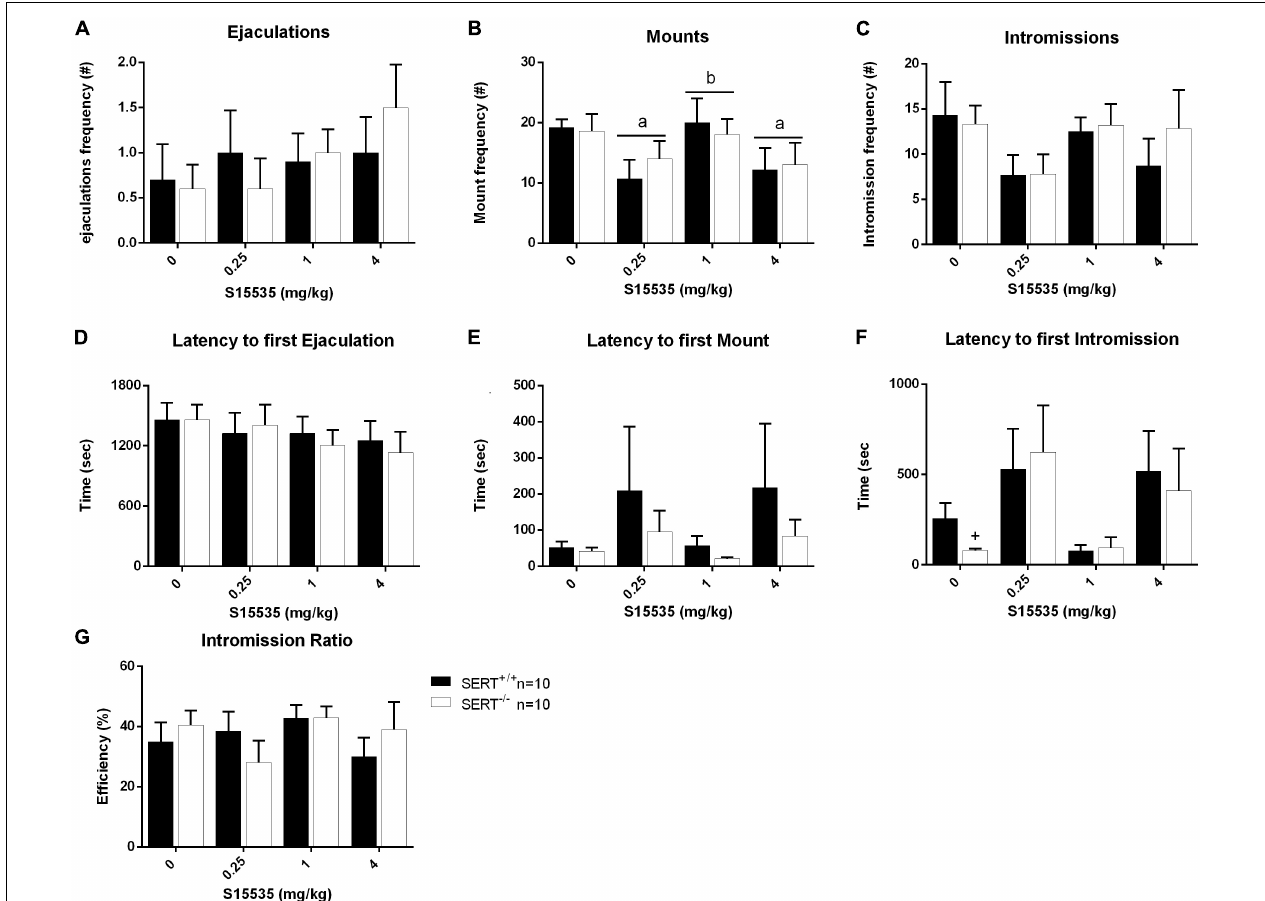
FIGURE 6 | Sexual behavior of male rats from slow ejaculating treated with 0, 0.25, 1, or 4 mg/kg S15535. The number and latency of ejaculations per 30 min (A,D) , number and latency of Mounts (B,E) , number and latency of Intromissions (C,F) and Intromission Ratio (G) of the first Ejaculation Series are given. Detailed statistical analyses are shown in Supplementary Table 4 . a: significant difference ( p < 0.05) compared to saline group, c: significant difference ( p < 0.05) compared to 1/mg/kg group. +Significant difference between SERT + / + and SERT − / − ( p < 0.05).